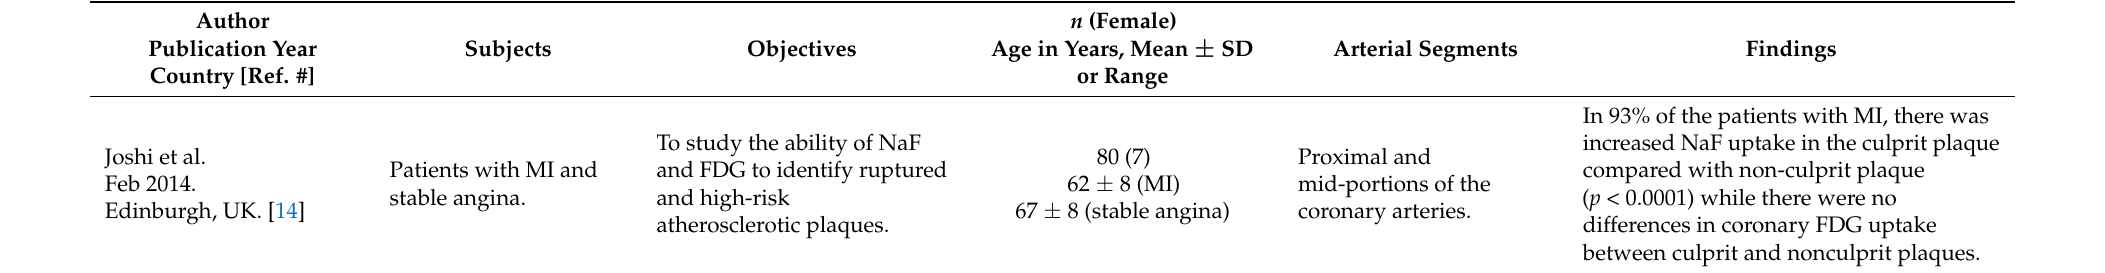
Table 2. Studies on the role of NaF in